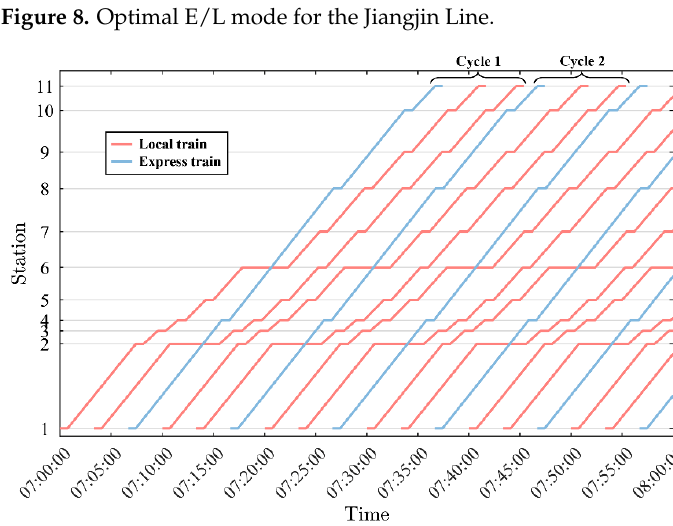
Figure 9. Timetable of the optimal solution result.